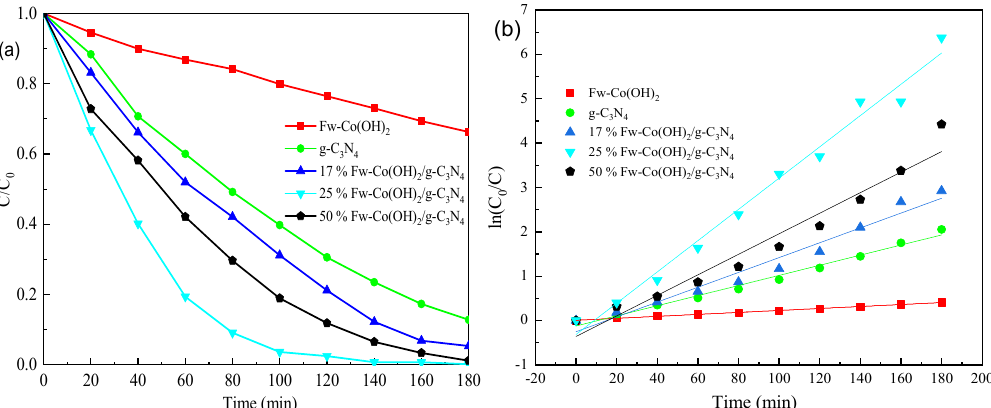
Figure 6. ( a ) Photo(electro) degradation of MB, ( b ) linear transform ln (C 0 /C) of the kinetic curves of MB using different catalysts (light intensity in visible light = 200 W, applied voltage = 200 W). Table 1. The apparent pseudo-first-order rate parameters of Fw-Co(OH) 2 /g-C 3 N 4. Sample